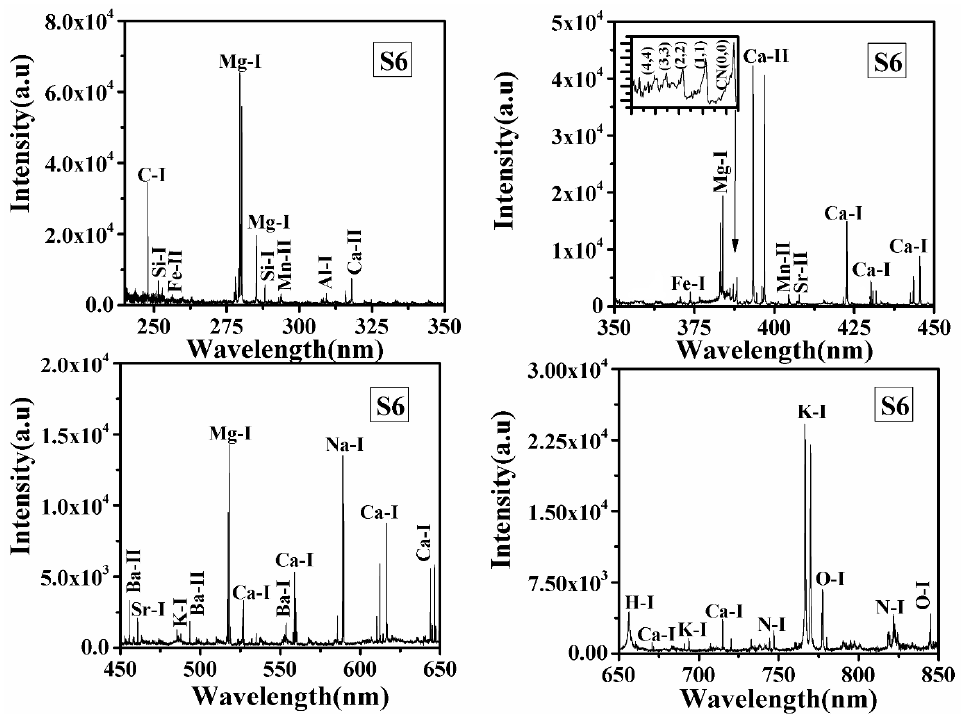
Figure 2. LIBS spectrum of natural turmeric sample (S6) in the spectral range from 240–350 nm, 350– 550 nm, 450–650 nm, and 650–850 nm.